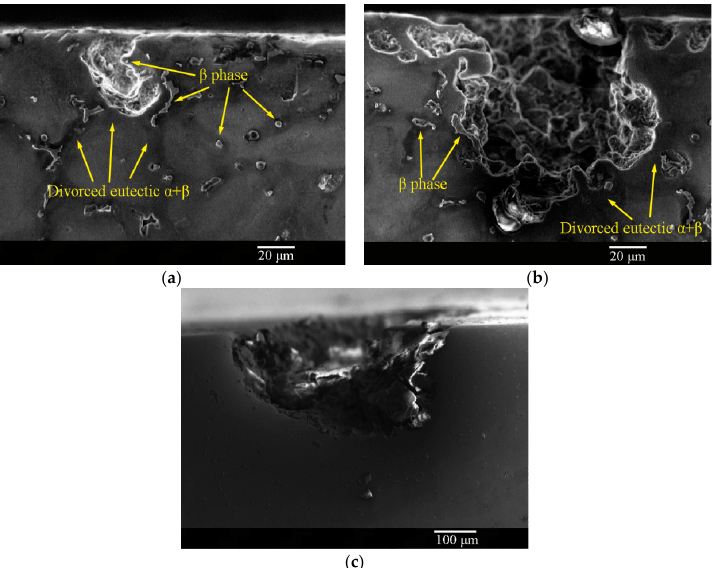
Figure 10. Cross-sectional morphologies of the corrosion pits on the ( a , b ) as-cast and ( c ) solid-solution-treated AM50 magnesium alloy samples pre-immersed in 3.5% NaCl solution for 24 h.